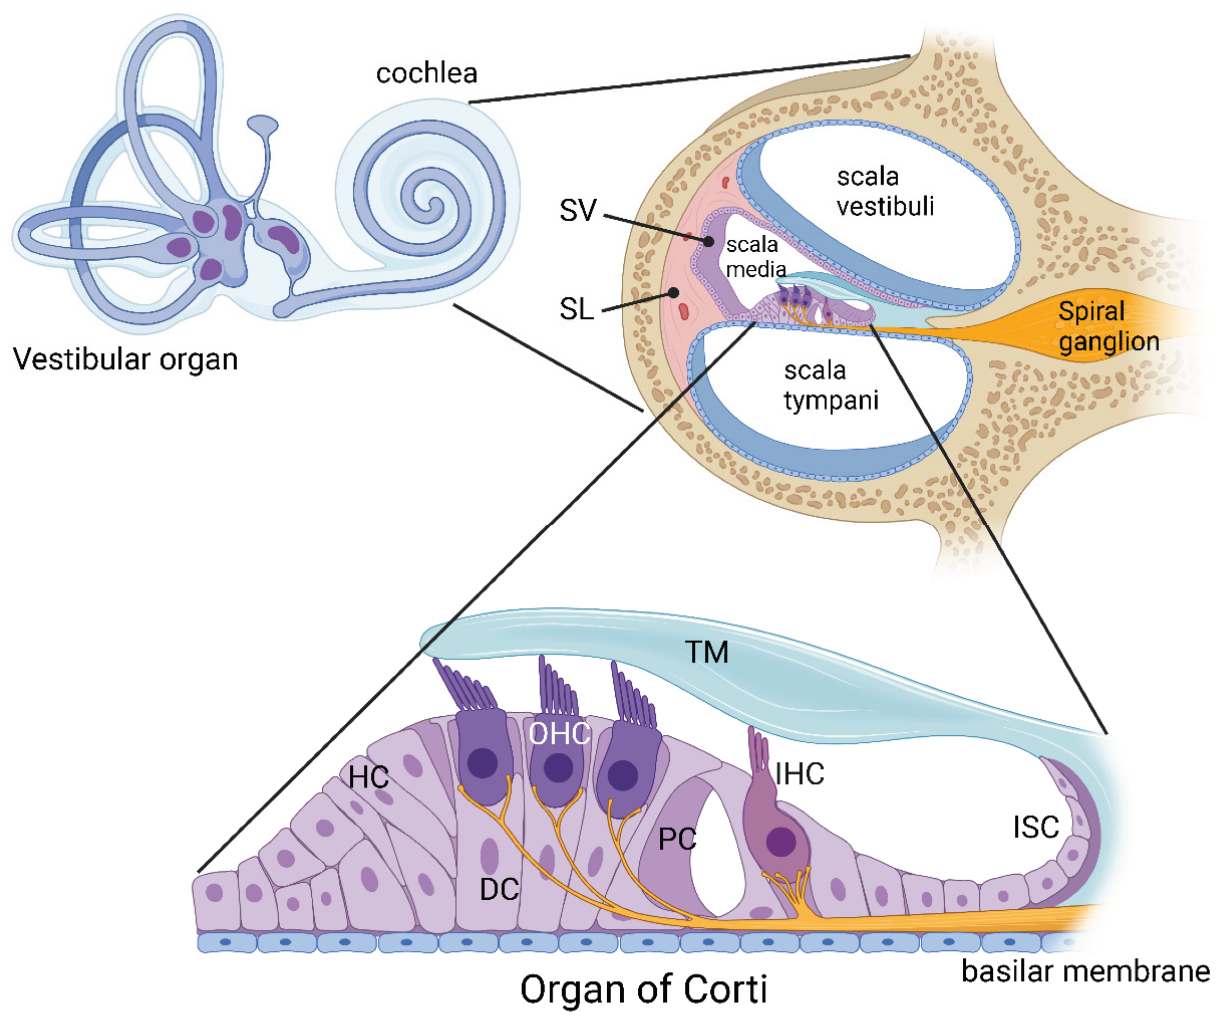
Figure 1. Inner ear anatomy. The mammalian inner ear contains two sensory organs, the organ of hearing (cochlea) and the organ of balance (vestibular organ). The cochlea comprises three fluid-filled compartments. Scala vestibuli and scala tympani contain Na + -rich perilymph, whereas scala media contains K + -rich endolymph. The lateral wall of the cochlea comprises the spiral ligament (SL) made up of fibrocytes, providing structural support to the secretory tissues of the stria vascularis (SV). The organ of Corti is the central structure for sensory transduction in the cochlea. It is covered by the tectorial membrane (TM) and contains two types of sensory cells, inner hair cells (IHC) and outer hair cells (OHC). These sensory cells are surrounded by supporting cells, such as Deiters’ cells (DC), Hensen’s cells (HC) and pillar cells (PC). The inner sulcus cells (ISC) are epithelial cells that form the medial border of the organ of Corti. Created with